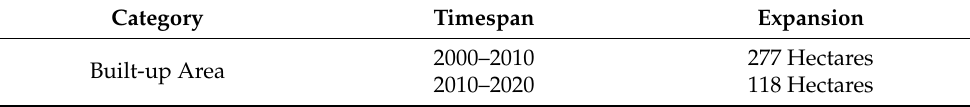
Table 5. The changes of built-up area in Batticaloa Municipality.